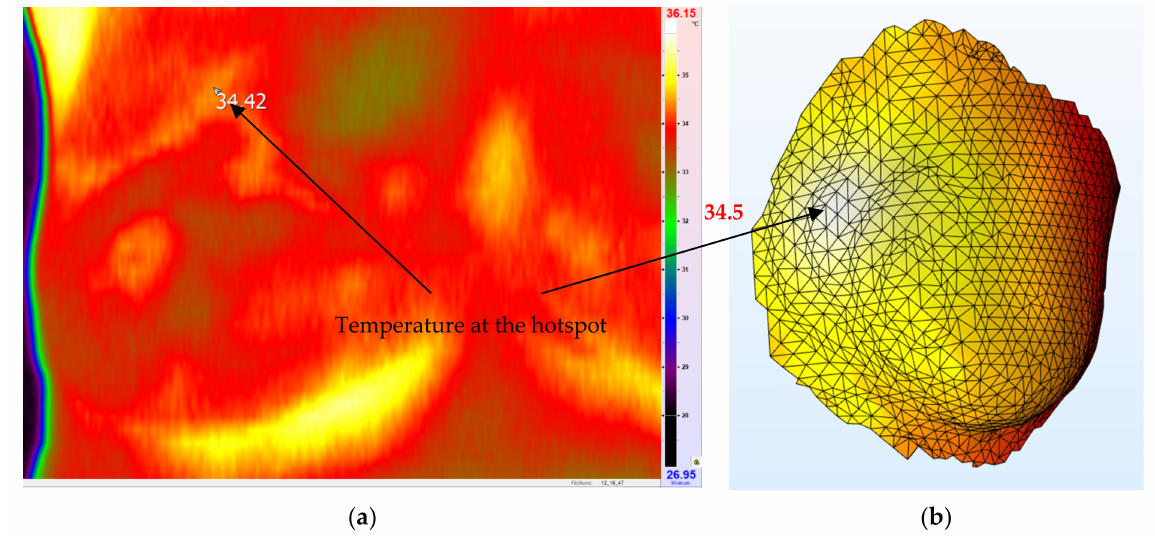
Figure 13. Comparison of measured ( a ) and computed ( b ) temperature distributions (patient No. 4) with a percentage error of 0.23% in hotspot temperature